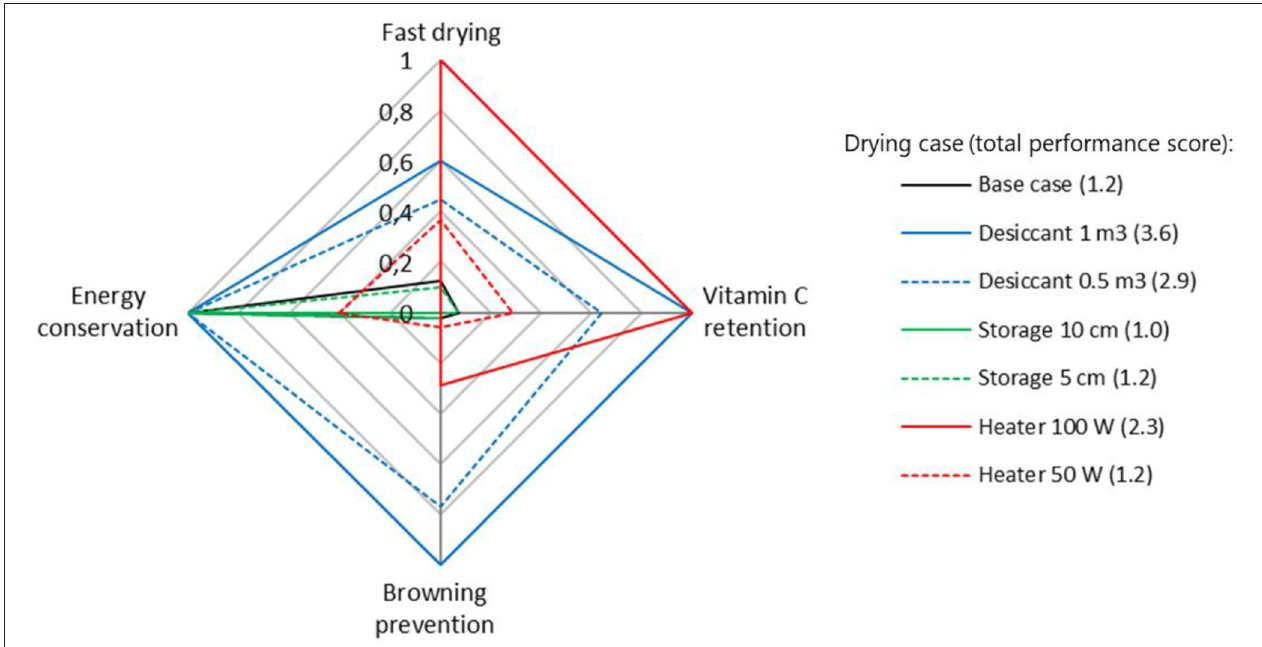
FIGURE 11 | Comparison of the performance of different solar drying strategies assessed by their abilities to conserve energy, shorten the drying time, preserve the vitamin C, and prevent the browning reaction. The value in each category is obtained by normalizing it against the worst (0) and best (1) performance. The number in the bracket is the total score in each drying case. Drying with 1 m 3 desiccant has the highest total score of 3.6. These data are only valid for the weather conditions specified in Figure 4